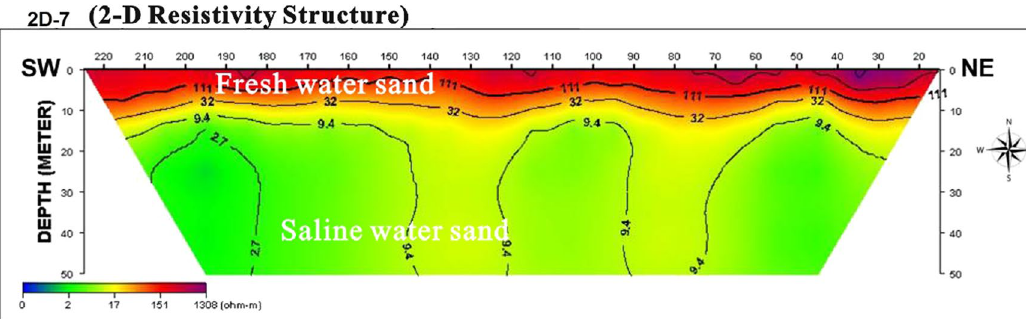
Fig. 11 Resistivity imaging of Traverse 2D-7